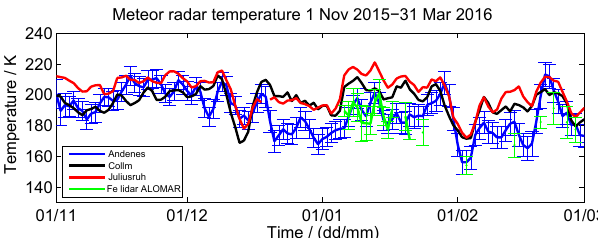
Figure 4. Mesospheric temperatures derived from three MR obser- vations and the ALOMAR Fe-lidar system for the winter season 2015/16. The error bars shown are given by the geophysical vari- ability within 24h. The temporal resolution of the lidar was de- creased to match the coarse resolution of the radar-derived temper-